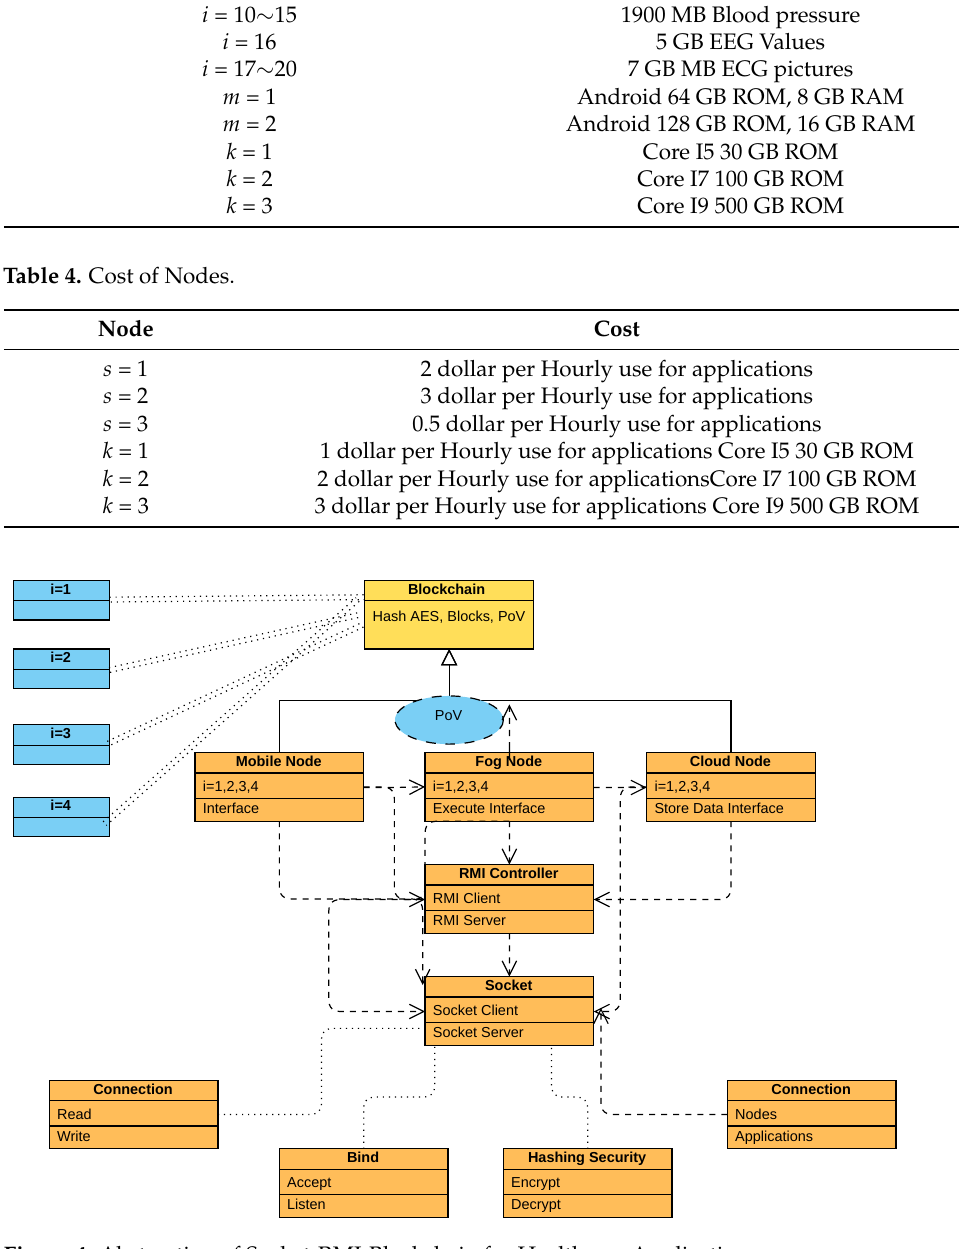
Figure 4. Abstraction of Socket-RMI-Blockchain for Healthcare